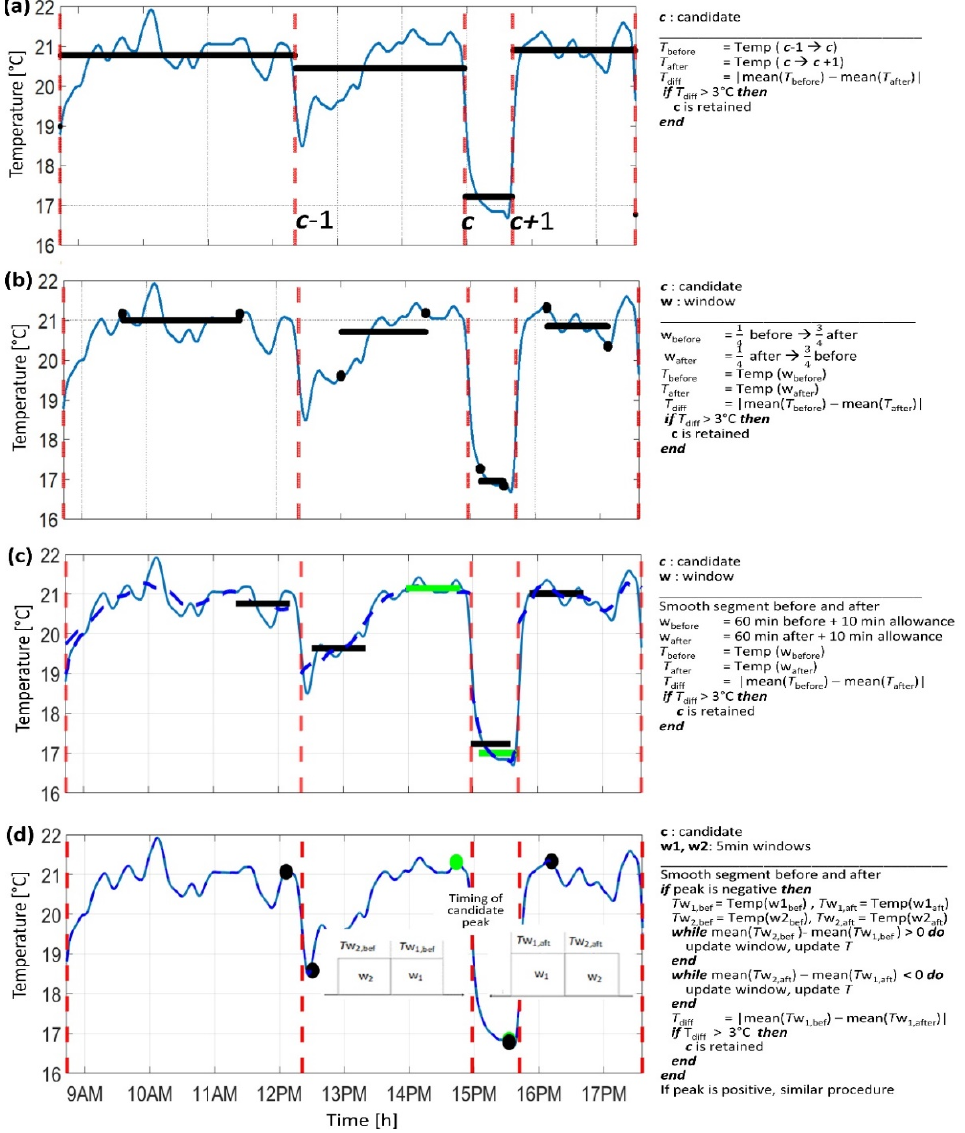
Figure 4. Analysis of the temperature signal around a candidate peak using four different approaches ( a – d ) for the selection of the signal segment to average the temperature level, estimate the level change, and skip or retain the candidate peak as an “event” associated with sensor removal/re-attachment. The dashed, red lines represent the candidates, and the horizontal lines and dots (black and green) represent the mean of the temperature over the windows adjacent to the candidate peak. The figure includes examples of the processed signal and the pseudocode corresponding to each